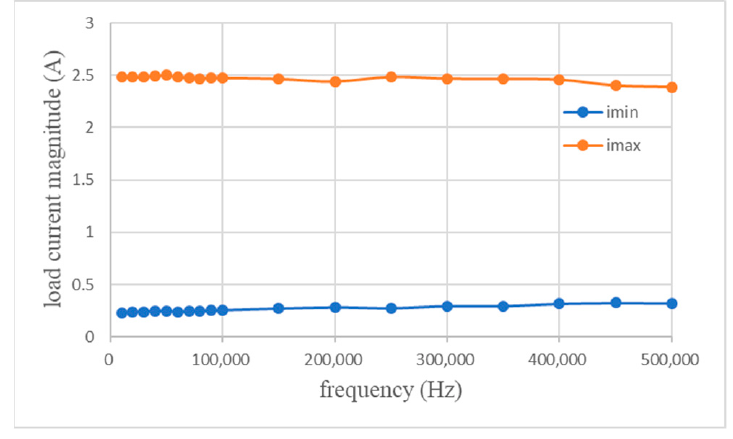
Figure 11. Range of load current amplitudes for soft switching at each frequency.